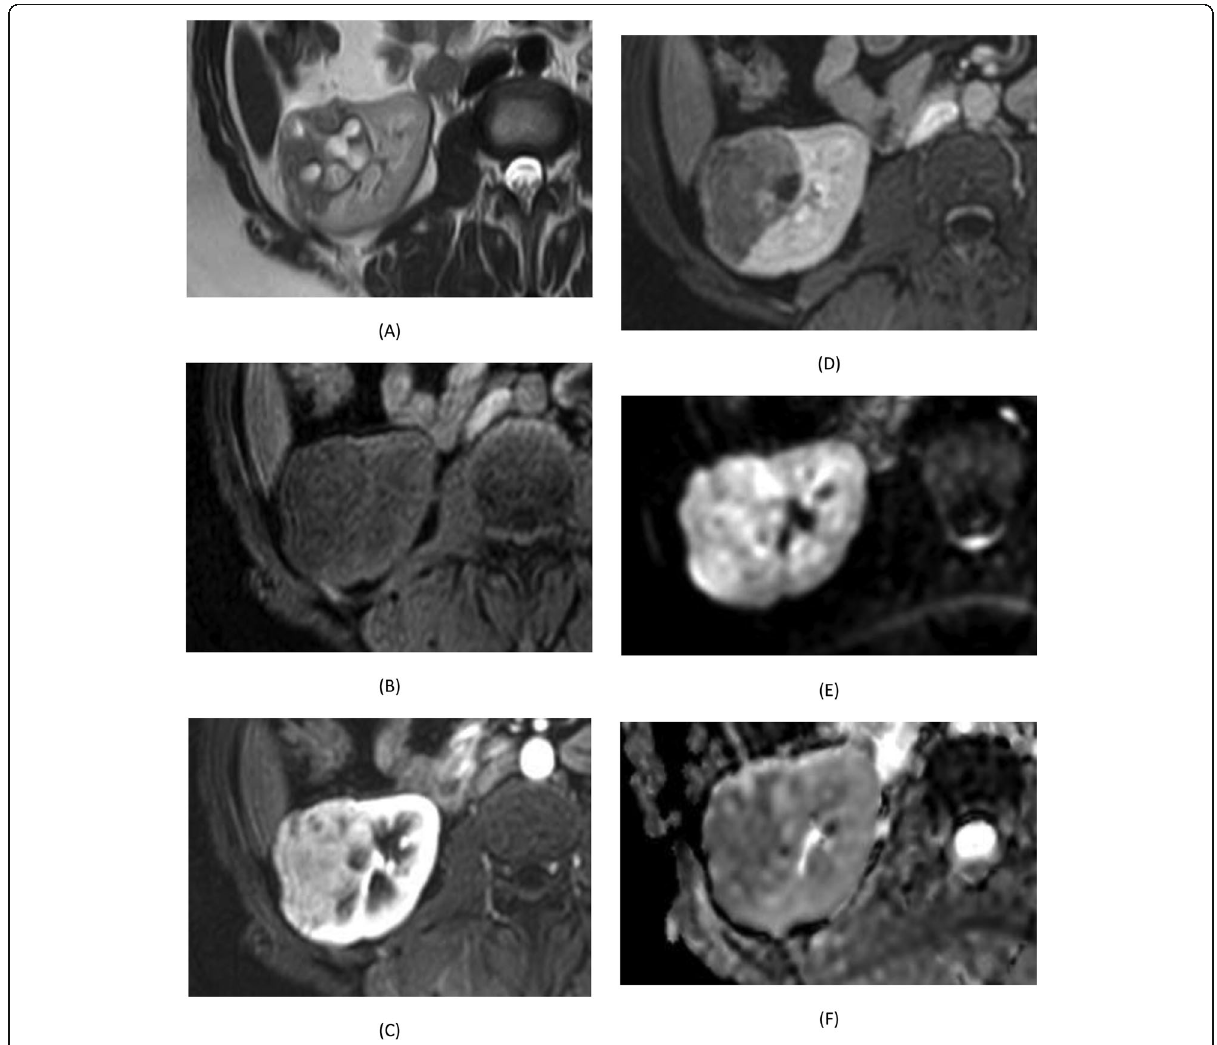
Fig. 5 Multiparametric MRI of cc-RCC. A case of right renal cc-RCC with small areas of necrosis, of a 30-year-old female. a Axial T2-WI shows the renal mass slightly lower SI compared with renal parenchyma. A ROI has been drawn and then reported on all sequences. Axial non-enhanced ( b ) and gadolinium-enhanced T1-W FS GRE-MR images in corticomedullary ( c ) and nephrographic ( d ) show early and intense heterogeneous enhancement of the solid components of the mass with washout at nephrographic phase. Axial DWI (b800mm 2 /s) ( e ) and ADC maps ( f ) show restricted signals corresponding the solid portion in the mass with ADC value (1.3 × 10 − 3 mm 2